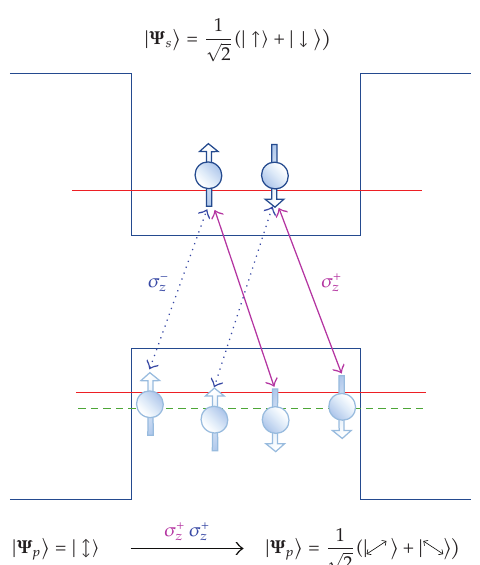
Figure 4: Spin state initialization for